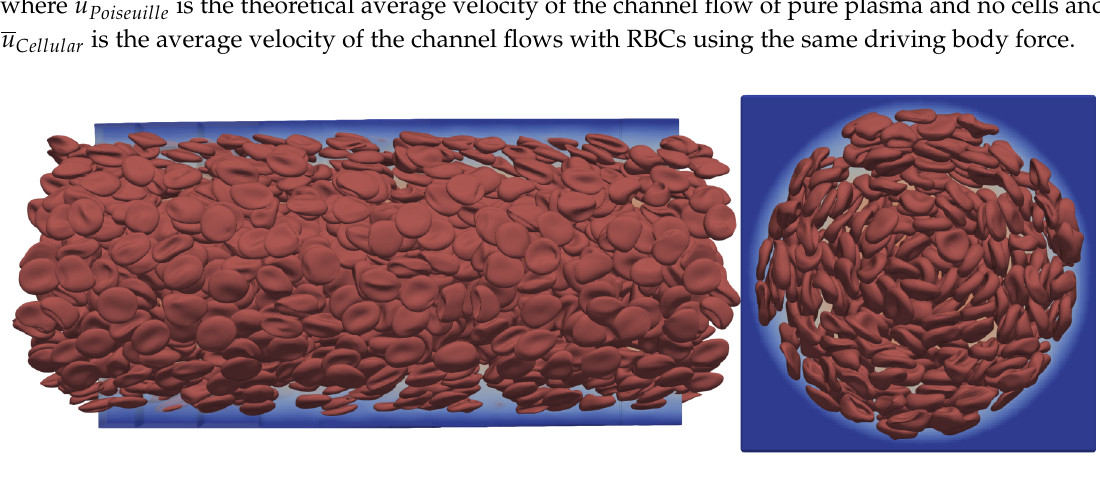
Figure 11. Side- and front-view visualisation of a circular channel flow simulation with a discharge haematocrit of H d =